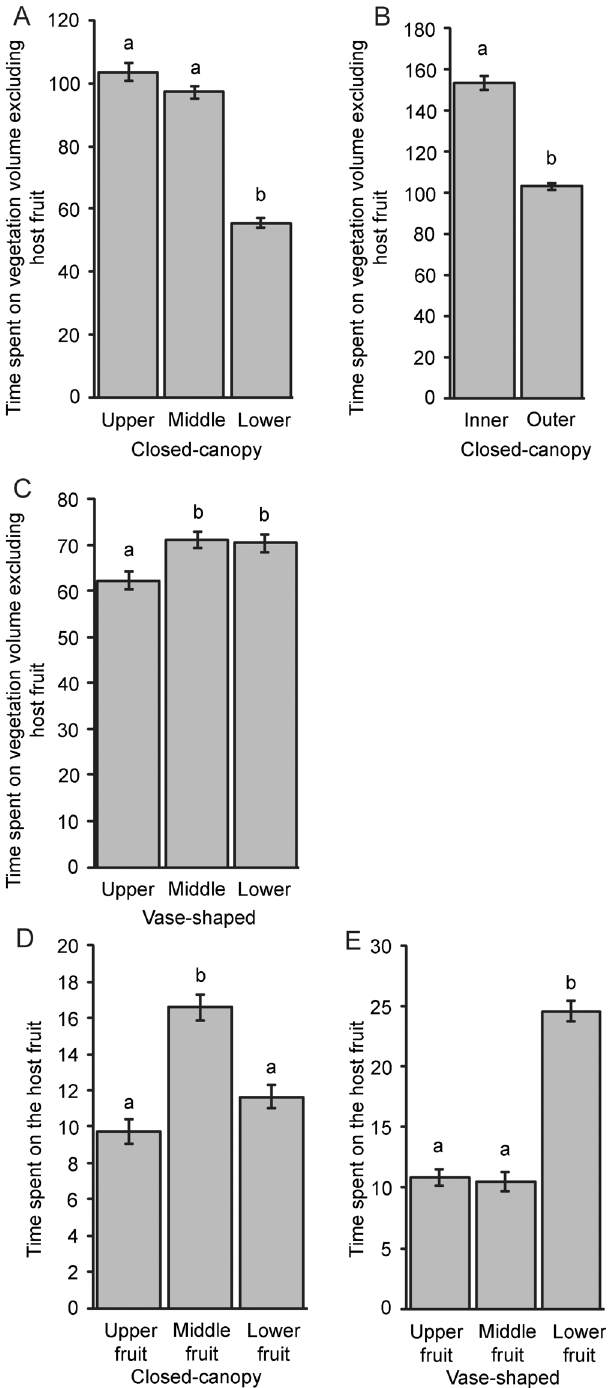
Fig 6. The results of closed-canopy tree and vase-shaped tree treatments. Mean time (min) spent by 30 Bactrocera tryoni on the vegetation volume and host fruit in each part of two types of tree canopy. Columns surmounted with the same letter are not significantly different at P = 0.05 (n = 50 simulations). A: upper vs. middle vs. lower (Mean = 103.70|97.24|55.58, F = 138.42, df = 2, P < 0.001). B: inner vs. outer (Mean = 153.48|103.04, t = 13.67, df = 49, P < 0.001). C: upper vs. middle vs. lower (Mean = 62.32|71.1| 70.44, F = 6.67, df = 2, P = 0.002). D: upper vs. middle vs. lower (Mean = 9.74|16.6|11.64, F = 26.53, df = 2, P < 0.001). E: upper vs. middle vs. lower (Mean = 10.84|10.5|24.62, F = 111.37, df = 2, P <